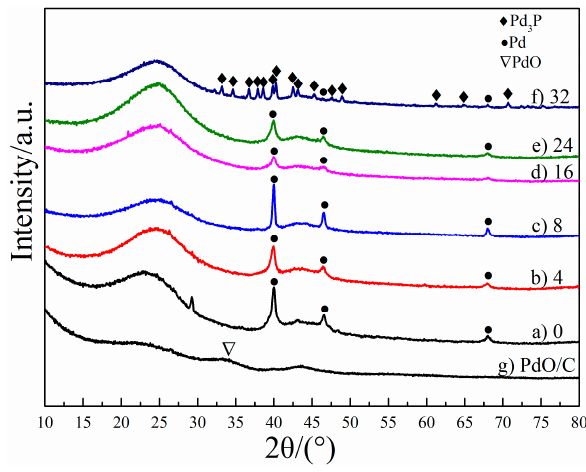
Figure 1. X-ray diffraction (XRD) patterns of Pd-P/C catalysts with different addition amounts of hypophosphite. ( a ) Pd-P(0)/C(400); ( b ) Pd-P(4)/C(400); ( c ) Pd-P(8)/C(400); ( d ) Pd-P(16)/C(400); ( e ) Pd-P(24)/C(400); ( f ) Pd-P(32)/C(400); ( g ) PdO/C without calcination treatment.